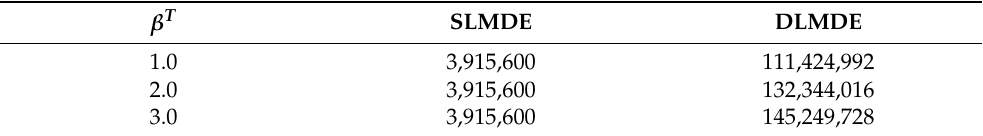
Table 4. Number of function evaluations required by both methods for Example